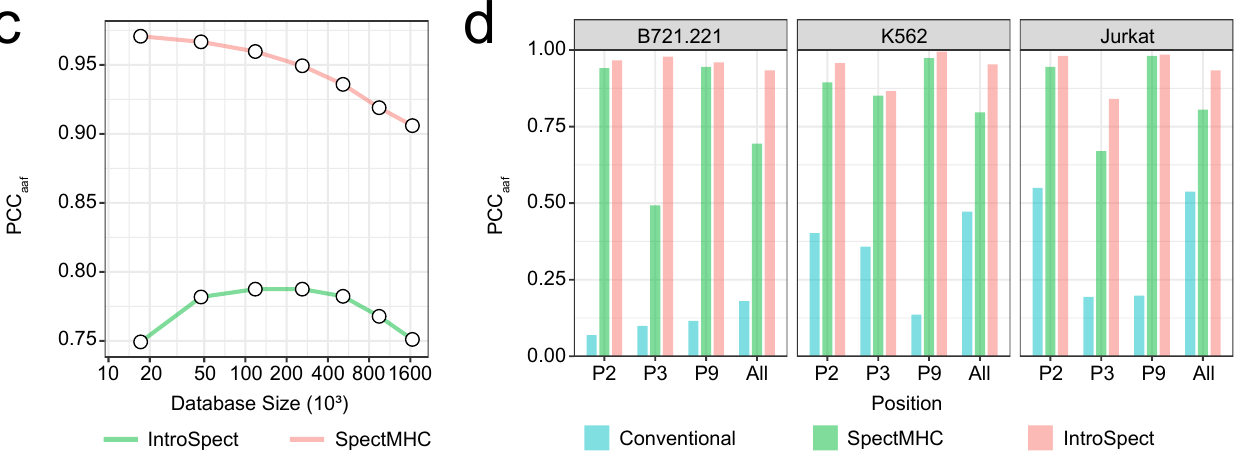
Figure 4. IntroSpect generates a smaller and more targeted database than that of SpectMHC. ( a ) The line plot compares the numbers of identified peptides by SpectMHC and IntroSpect on databases with various matching sizes. The data point with an asterisk corresponds to the motif score of 0.3, the empirically chosen optimal threshold for IntroSpect. ( b ) The bar plot shows the relationship between the databases and identified peptides of IntroSpect and SpectMHC on databases with various sizes. ( c ) The line plot comparing the PCC aaf by SpectMHC and IntroSpect search on databases with various sizes. ( d ) PCC aaf at P2, P3, P9 and all positions between the databases and identified peptides by SpectMHC, IntroSpect and conventional search on the three datasets (B721.221, K562 and